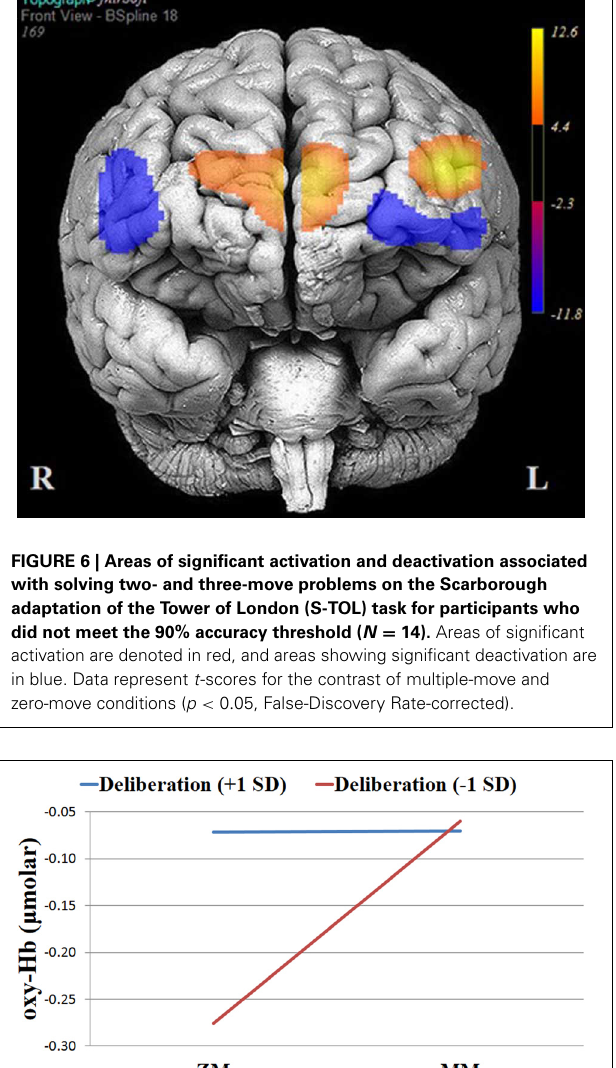
that increased activity in the right portion of the medial PFC may also play a role in solving unambiguous problems which vary in search depth.